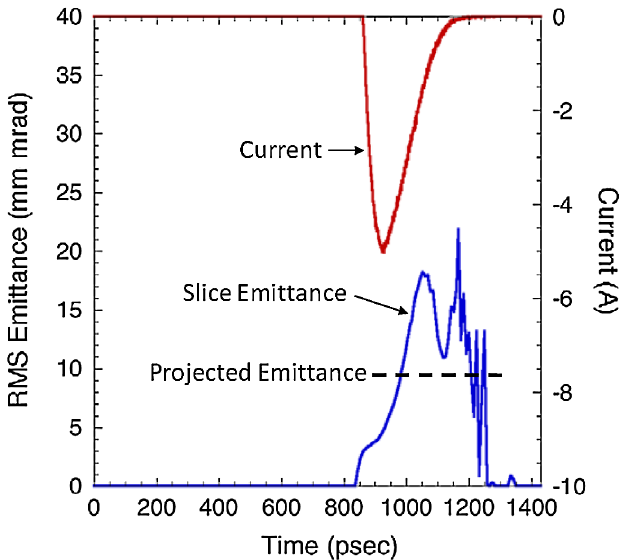
FIG. 11. Simulated current and emittance at the anode for the geometry shown in Fig. 9. The red curve shows the current and the blue curve shows the slice emittance. The slice emittance at the peak of the current pulse is " n; ? (cid:1) 5 mm mrad . The pro- jected emittance " n; ? ¼ 8 : 9 mm mrad is shown by the dashed horizontal line.